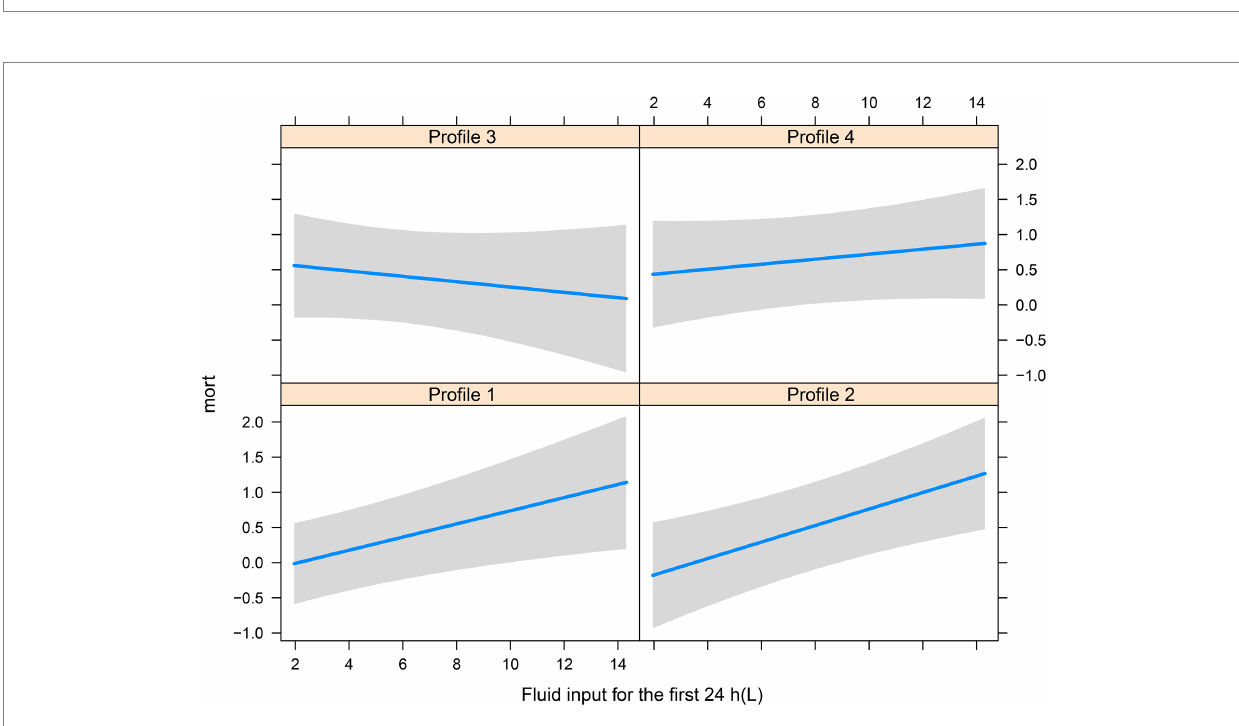
FIGURE 6 Fluid intake and risk of hospital mortality, stratified by four subphenotypes.